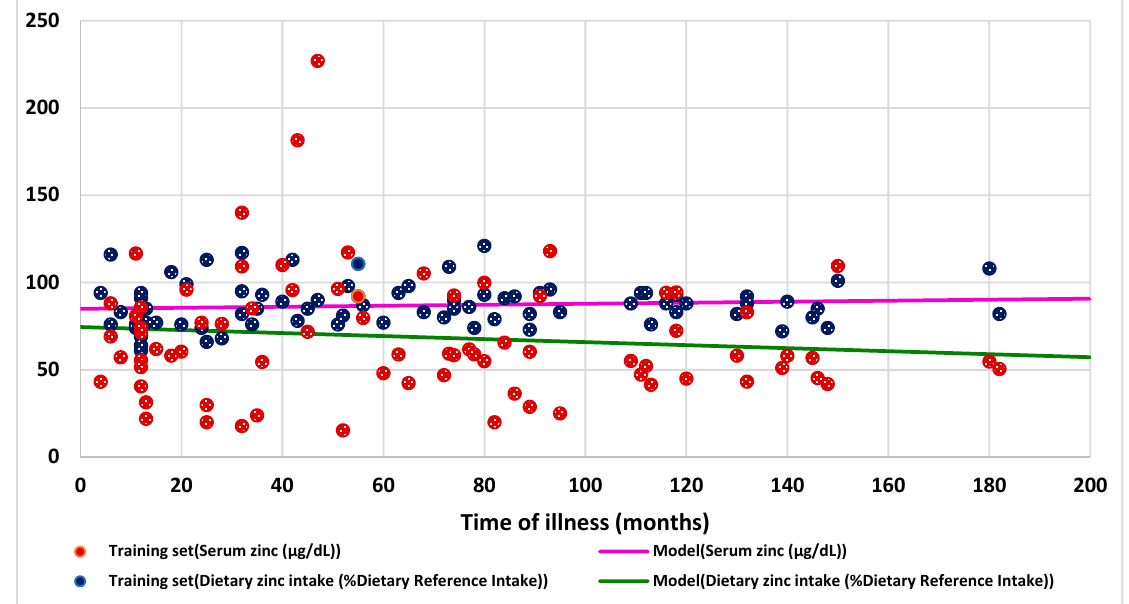
Figure 4. Correlation between serum zinc, dietary zinc intake, and the time of illness in the entire series ( N = 78). Table 1. Baseline characteristics of the children with chronic disease ( N = 78 *).